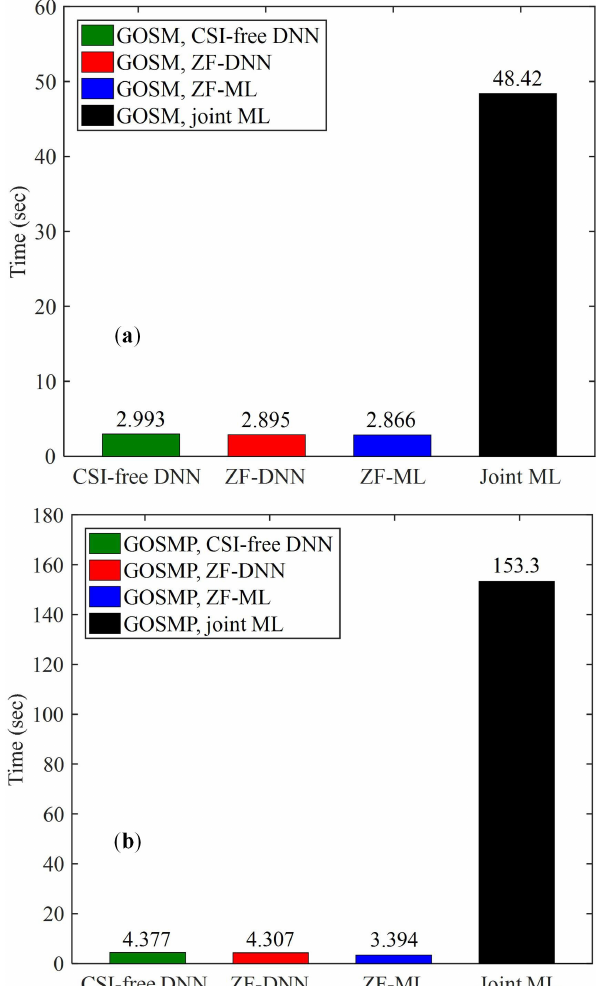
Figure 8. Computation time comparison of the proposed CSI-free DNN detector and three benchmark detectors for ( a ) GOSM and ( b ) GOSMP at the center of the receiving